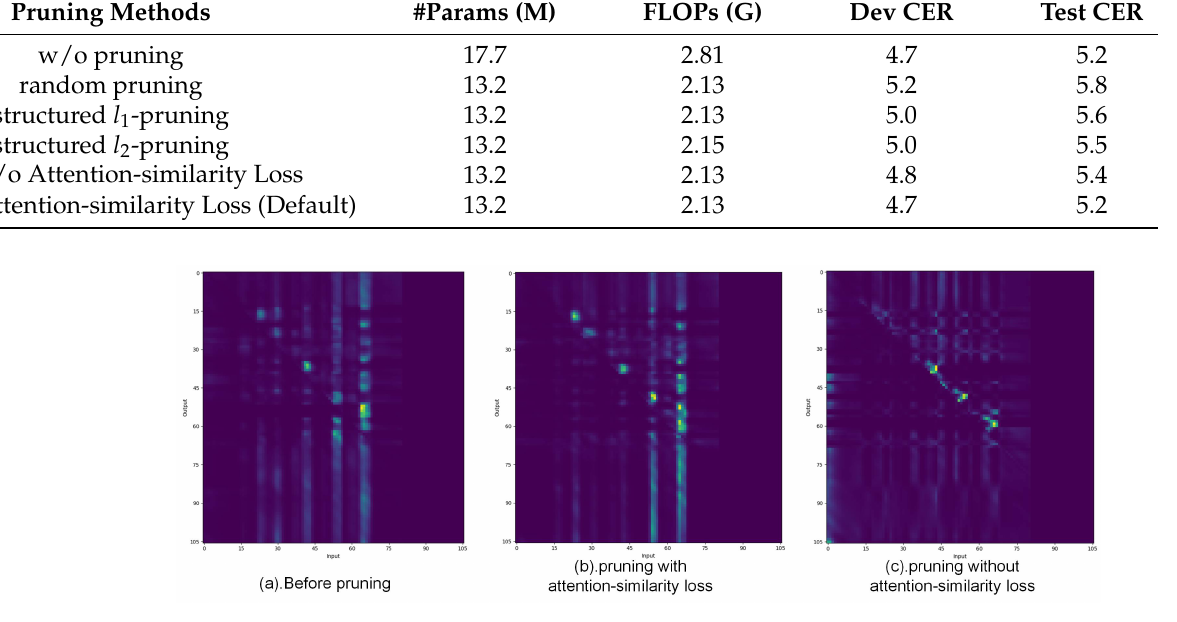
Figure 4. Visualized attention weights. ( a ) is the original attention weight without any pruning, ( b ) is the attention weight pruned with the attention-similarity loss, and ( c ) is the attention weight pruned without the attention-similarity loss.